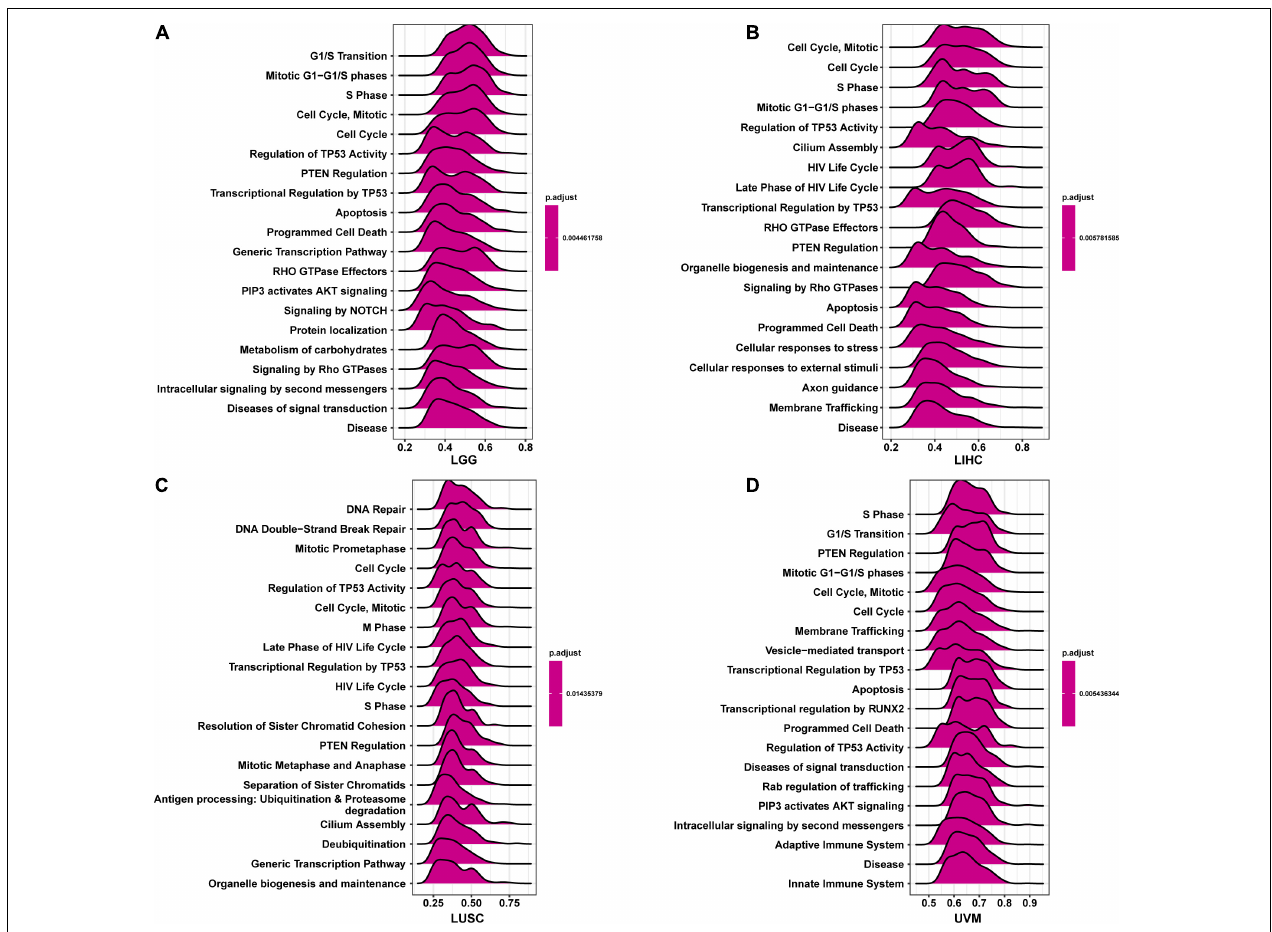
FIGURE 7 | GSEA of CCDC137 in TCGA pan-cancer. (A–D) The top 20 GSEA results of CCDC137 in indicated tumor types from TCGA.